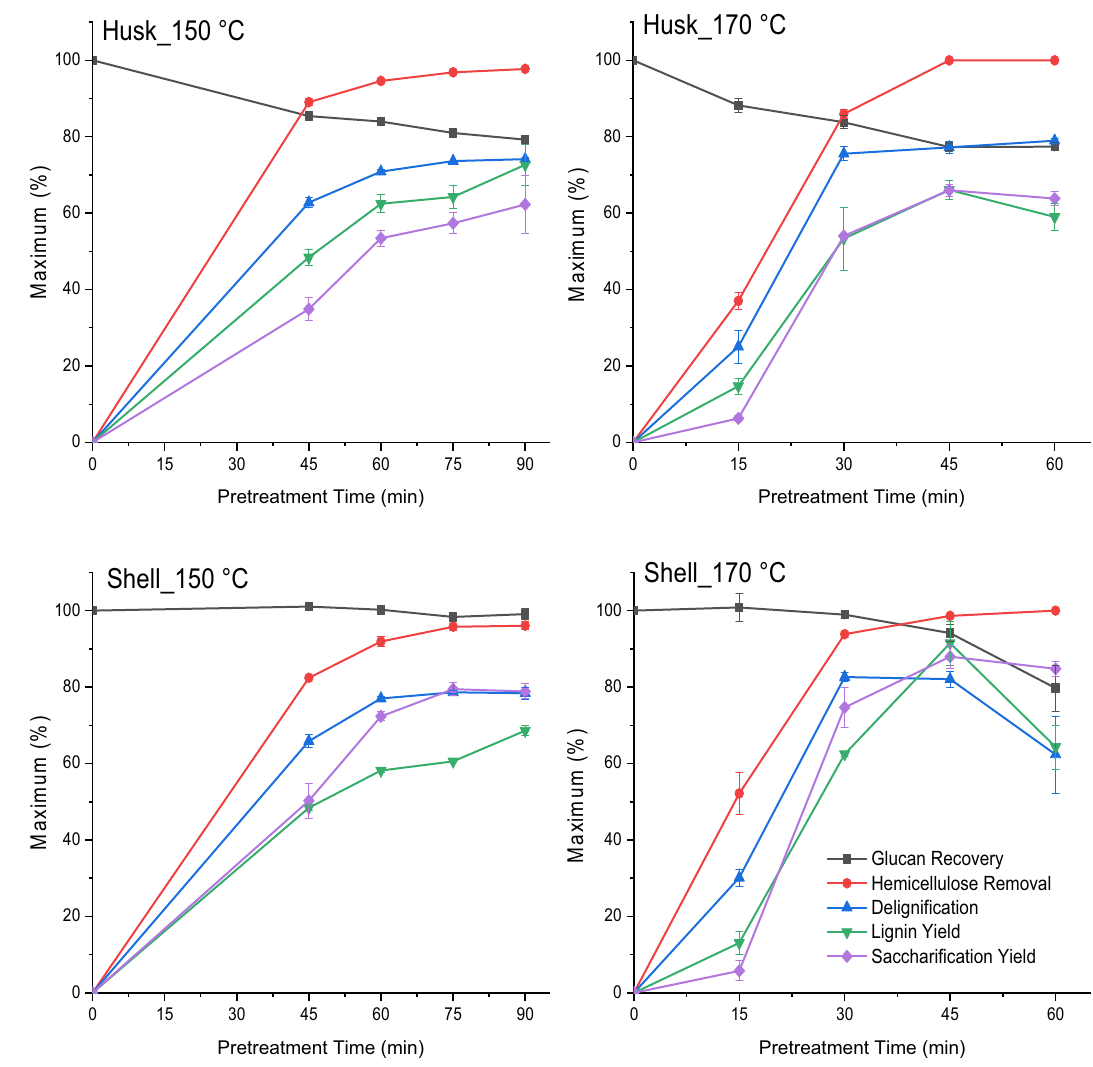
Figure 1. Performance indicators for ionoSolv pretreatment of husk and shell with [DMBA][HSO 4 ] (20 % water content) in 1:10 g/g biomass: solvent loading at 150 for 45–90 min and 170 °C for 15–60 min (Error bars represent standard deviations for three replicate measurements).